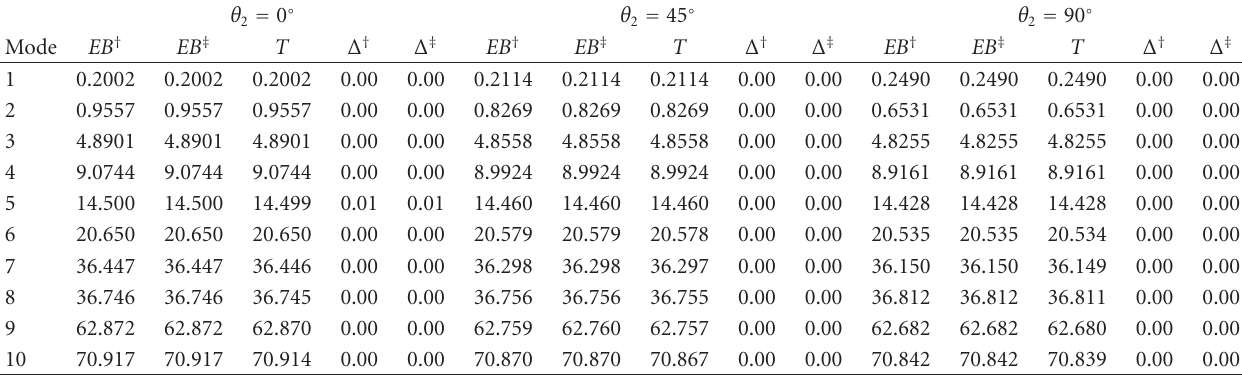
Table 2: First ten natural frequencies (Hz); two-link manipulator, see Table 1; ( L 1 /h = 833 . 3, L T /h = 1733).